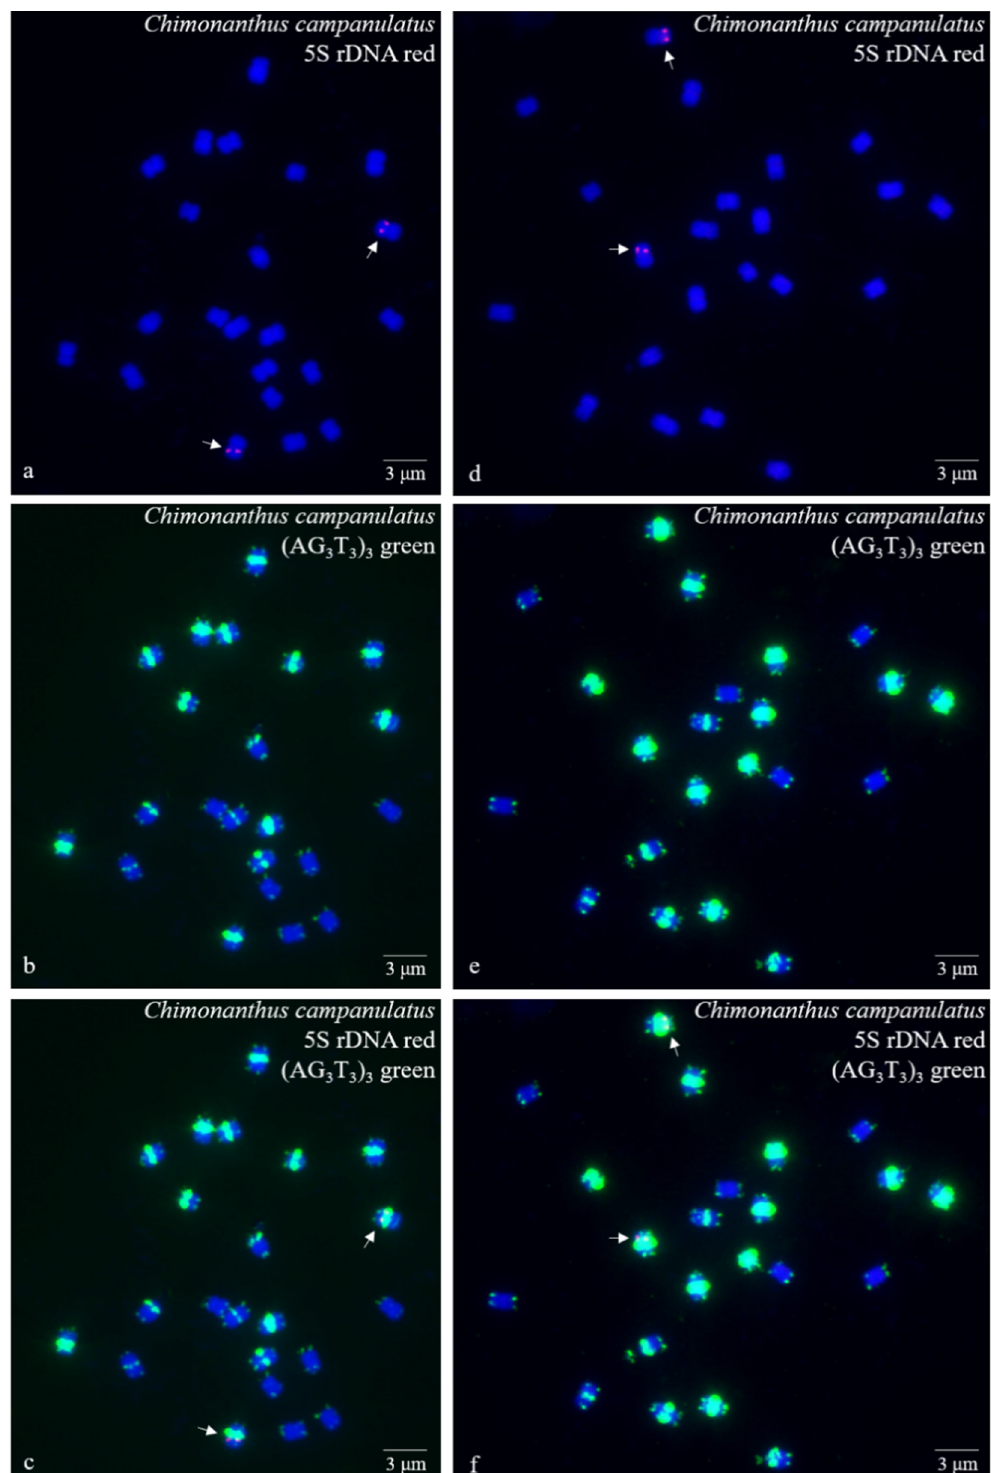
Figure 2. Mitotic metaphase (development stage) chromosomes of Chimonanthus campanulatus after FISH. Two spreads are presented in Figure 2 a – c and Figure 2 d – f . The probe oligo – 5S rDNA result with chromosomes visualized by TAMRA (red, white arrows) is shown in Figure 2 a , c , d , f , whereas the probe oligo – (AG 3 T 3 ) 3 result with chromosomes visualized by FAM (green) is shown in Figure 2 b , c , e , f . Chromosomes were counterstained by DAPI (blue) in all images. Scale bar = 3 μ M.